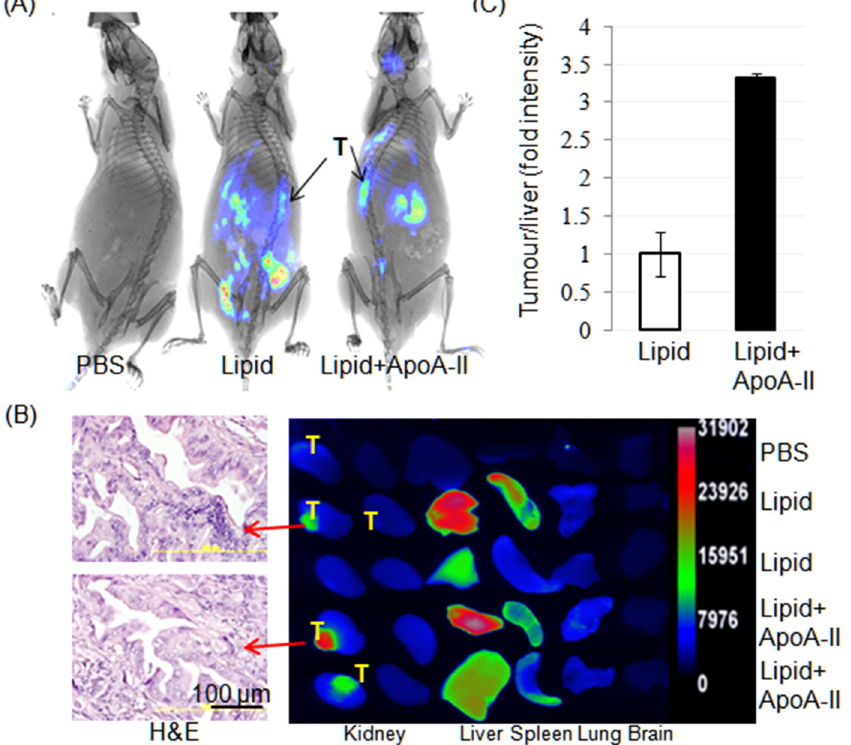
Fig 3. SMOFlipid ApoA-II targets pancreatic ductal adenocarcinoma (PDAC). (A) Spectral reflectance fluorescence images of 8 week old xenografts taken 48h after tail vein injection of PBS, DiD labeled SMOFlipid without or with ApoA-II using Carestream molecular imaging. Note the widespread distribution of DiD is better localized to the tumours when ApoA-II is included with lipid. Arrows indicate the site of tumours. (B) Spectral fluorescence images of explanted tumours and organs taken 48h after injection from mice after a tail vein injection of either PBS, lipid/DiD (n = 2) or lipid/DiD plus ApoA-II (n = 2) (right panel) along with the H&E photo micrograph of the tumour from two mice (left panel), retained the morphological characteristics with the original patient ’ s PC tumours in lipid and lipid plus ApoA-II treated mice. Note the uptake of fluorescence by the tumours, liver and spleen. (C) Graph represents the uptake by the tumour relative to the uptake of the liver as a fraction of area. These results were then normalised to the value for mice receiving lipid only (defined as 1) when the tumour uptake for the mice receiving lipid and ApoA-II had 3.4 fold increased uptake. Values are mean ± SD; n =